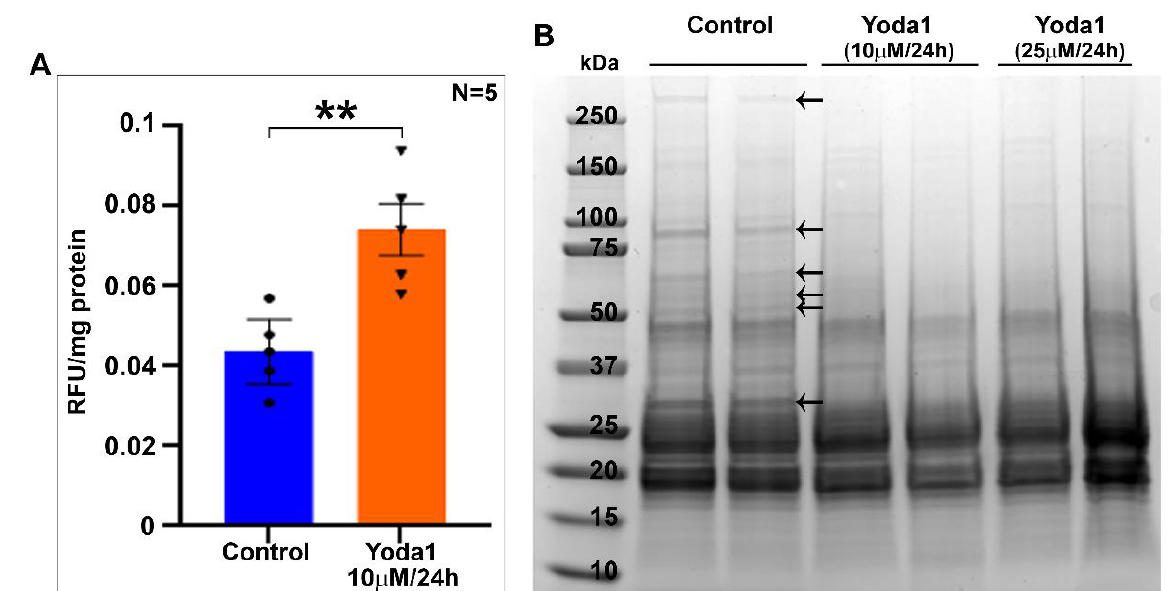
Figure 6. Piezo channel agonist Yoda1 treatment induces calpain activity and membrane protein proteolysis in lenses. ( A ). Calpain activity, which is calcium-dependent, was evaluated in mouse lenses treated (ex vivo) with 10 µ M Yoda1 for 24 h. A significant increase (by ~69%, n = 5) in calpain activity was detected in the treated lenses compared to the control lenses. Values are represented as Mean ± SEM. ** p < 0.01. RFU: Relative fluorescence units. ( B ). Having found increased calpain activity and haziness in Yoda1-treated lenses, we then examined the integrity of lens membrane protein fractions derived from the Yoda1-treated (10 and 25 µ M for 24 h) and control lenses by SDS-PAGE analysis. As shown in the figure, the Coomassie-blue-stained SDS-PAGE profile of the membrane-enriched fraction from Yoda1-treated lenses showed a markedly reduced staining of several protein bands (indicated with arrows) compared to the control lenses, indicating increased proteolysis, perhaps due to increased calcium-dependent calpain activity associated with Piezo1 activation ( A ). Data are shown for two representative lenses per